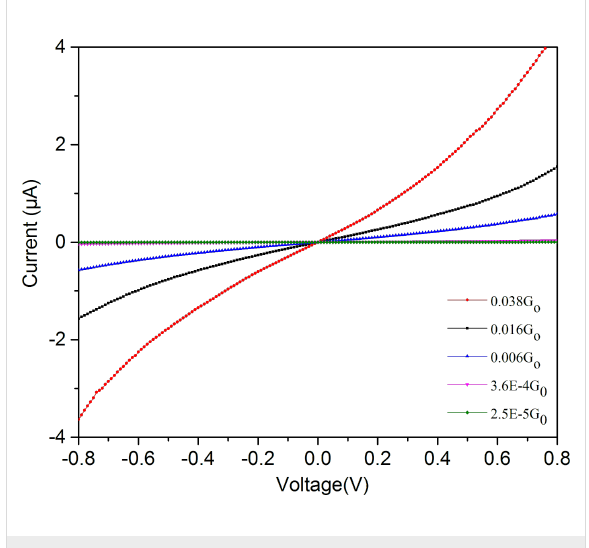
Figure 6: I – V -curves for the M1 molecule at the conductance values indicated (measured close to 0 V at room temperature).